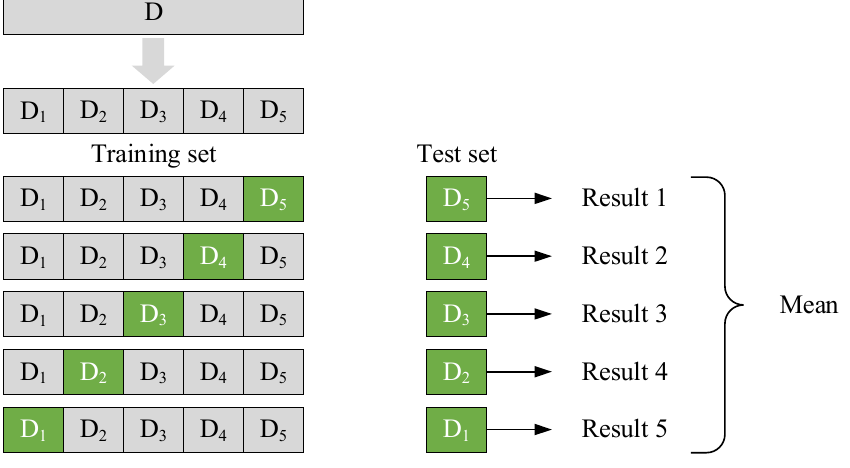
Figure 8. Schematic diagram of five-fold cross-validation.